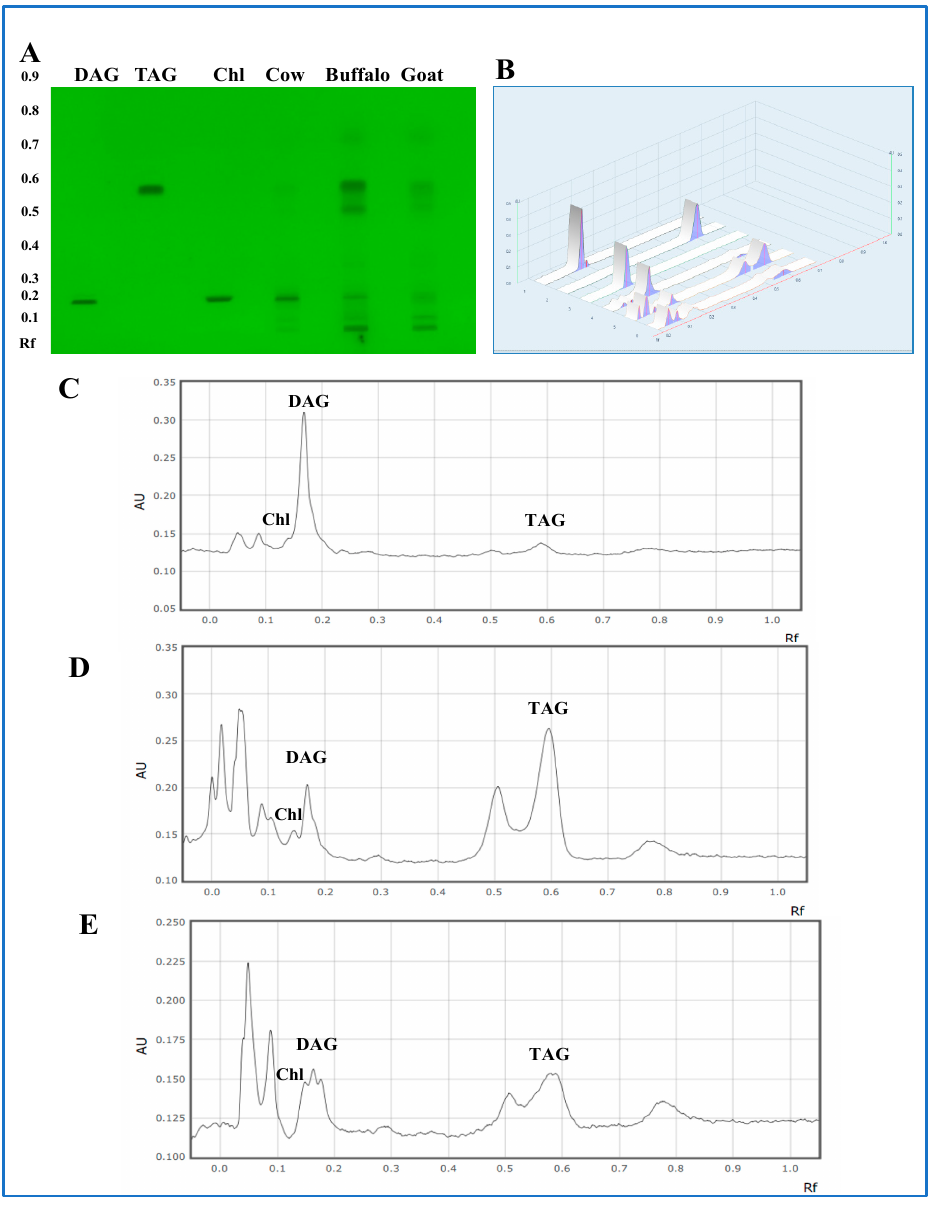
Figure 2. Analysis by high-performance thin-layer chromatography of ( A ) neutral lipid standards and animal groups visualized under UV light at 254 nm after derivatization with iodine vapors. Neutral lipid standards loaded at different volumes from track 1–3 and milk samples in track 4–6; ( B ) high-performance thin-layer chromatography 3-D densitogram; Chromatogram of ( C ) cow, ( D ) water buffalo, and ( E ) goat milk neutral lipids. Representative image of three independent biological samples performed in triplicate.